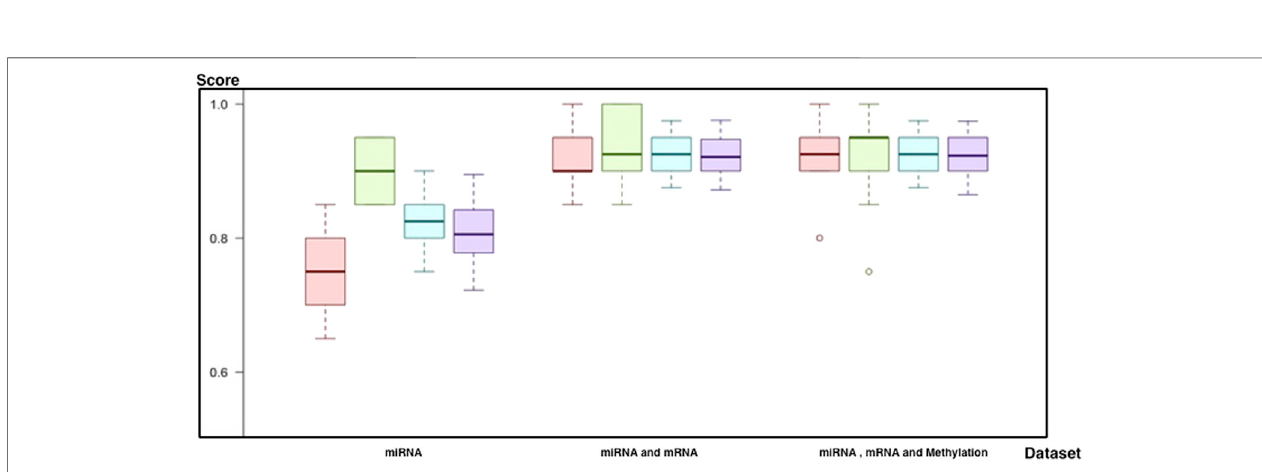
FIGURE 8 | Model comparison of techniques used for miRNA, mRNA, and methylation biomarkers (red, sensitivity; green, predictivity; blue, accuracy; purple, F-score). The model listed in 4, which applies (d3), is selected as the successor model for the fi nal cycle.